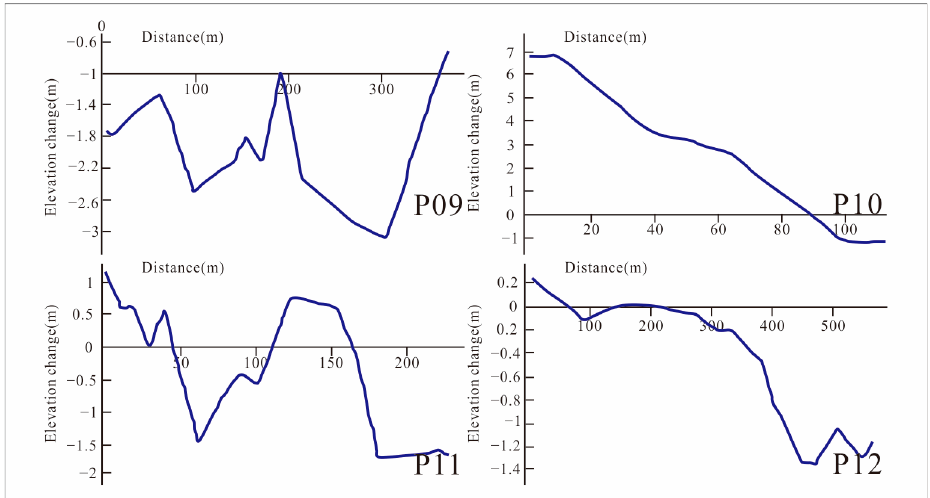
Figure 12. Elevation change in cross-section (P09 to P12).